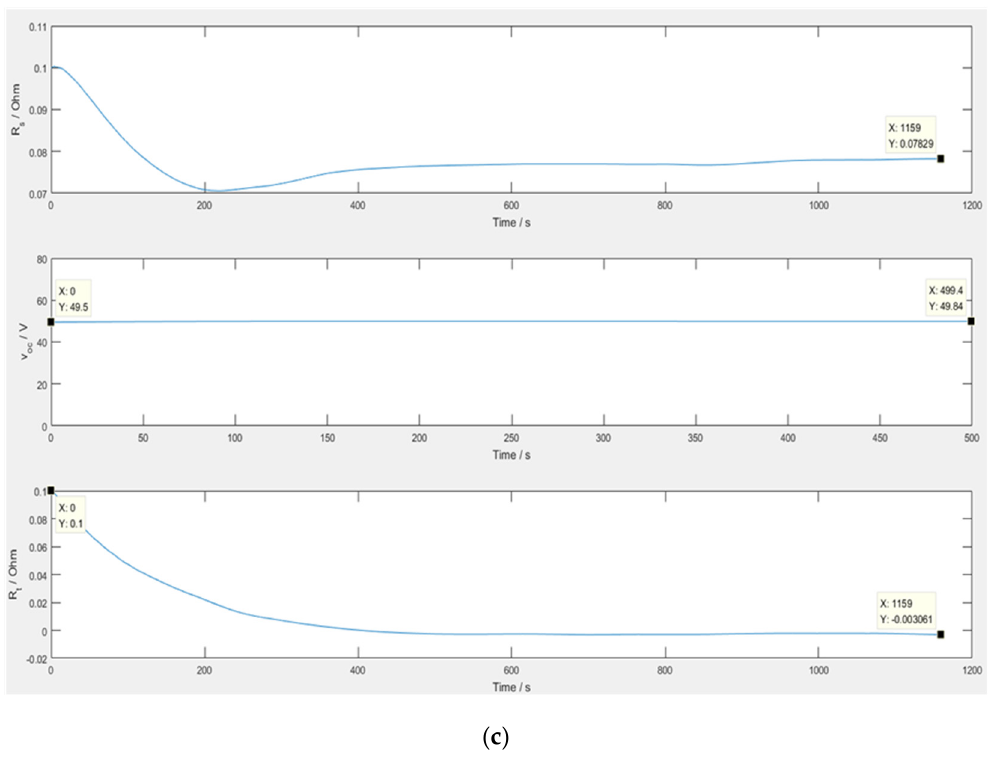
Figure 8. ( a ) Terminal voltage, discharge current, and estimating error; ( b ) estimating model parameters, θ(cid:3552) (cid:3036) , i = 1~4; ( c ) estimated Rs, Rt, and voc in Experiment 2.